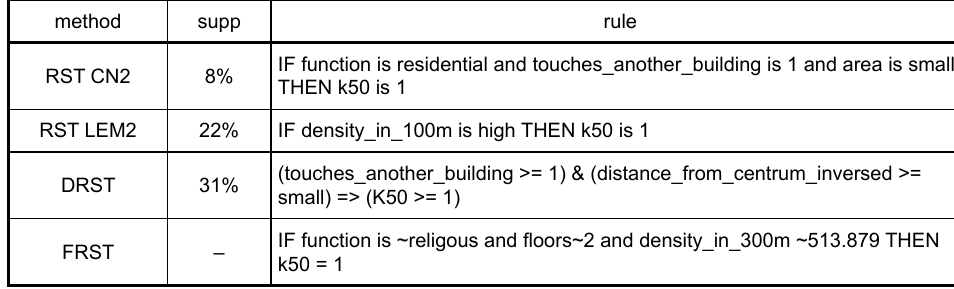
Table 6. Examples of rules for the selection of buildings (source: own work, based on A. Fiedukowicz 2017) method